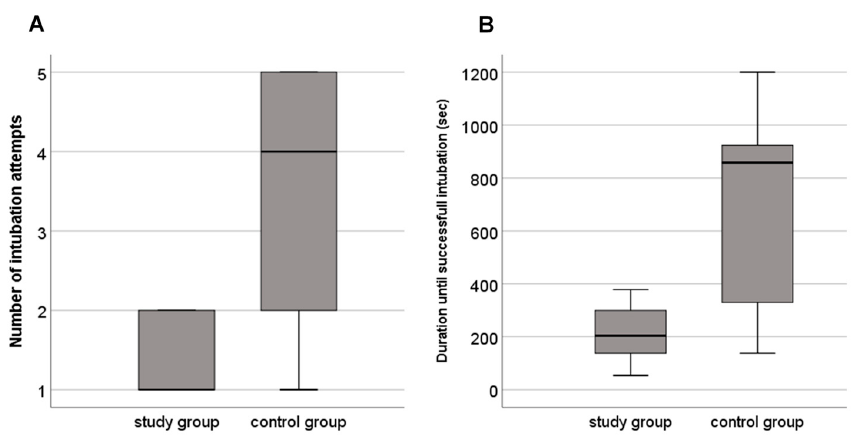
Figure 2. Boxplots of ( A ) number of intubation attempts and ( B ) duration until successful intuba- tion in neonates intubated with the novel intubation method (study group) and the conventional intubation method (control